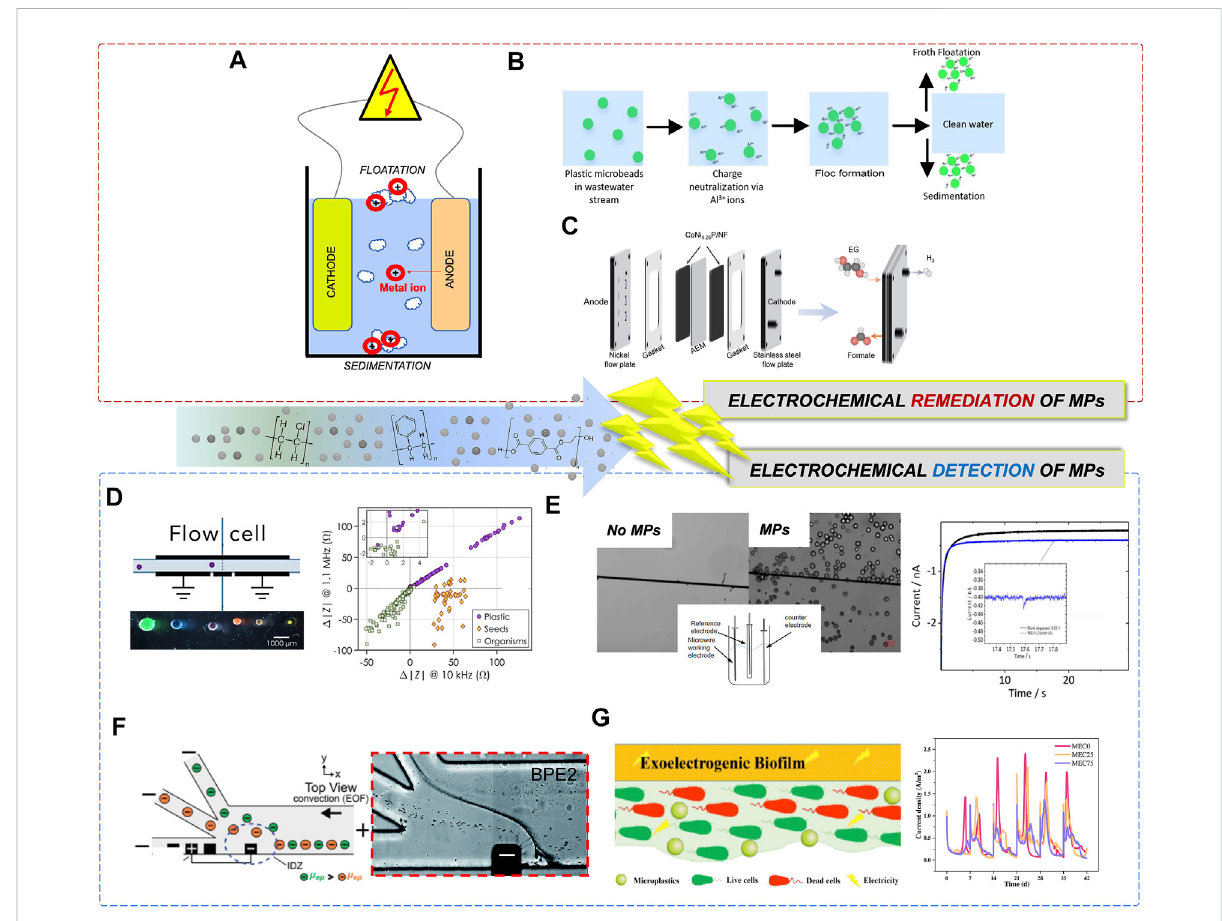
FIGURE 1 Illustration of electrochemical remediation and monitoring approaches for MPs. (A) Schematic of microplastic removal from water by electrocoagulation process. (B) Schematic of electrocoagulation of microbeads from waste water (Perren et al., 2018). (C) Membrane-electrode assembly (MEA) for electrooxidation of polymer breakdown products, speci fi cally ethylene glycol oxidation into formate (Zhou et al., 2021). (D) The schematicofMPspassingthrougha fl owcellforimpedancemeasurements(left).Changeinimpedanceasafunctionofparticletype:organism, seeds, or plastic (inset shows little overlap between plastic and organism indicating excellent differentiation abilities) (Colson and Michel, 2021). (E) Optical microscopy images of the carbon fi ber electrode in the absence and presence of MPs (left). The chronoamperogram (right) of the PE MPs (blueline)andintheabsenceofMPs(blackline)(theinsetprovidesanenlargedviewofatransientcurrent-timesignalresultingfromacollisionevent between MP and electrode (Shimizu et al., 2017). (F) Schematic of a device for continuous MP sorting based on MP electrophoretic mobilities, showing BPE across microchannel. Optical image (left) of two types of MPs (different sizes) being nearly qualitatively sorted into the middle and top outlet channels according to their electrophoretic mobility (Davies and Crooks, 2020). (G) Schematic of exoelectrogenic bio fi lm on electrode surface and its interactions with MPs (left). Current density output in MEC as a function of increasing MP concentrations (right) (Wang et al., 2022).